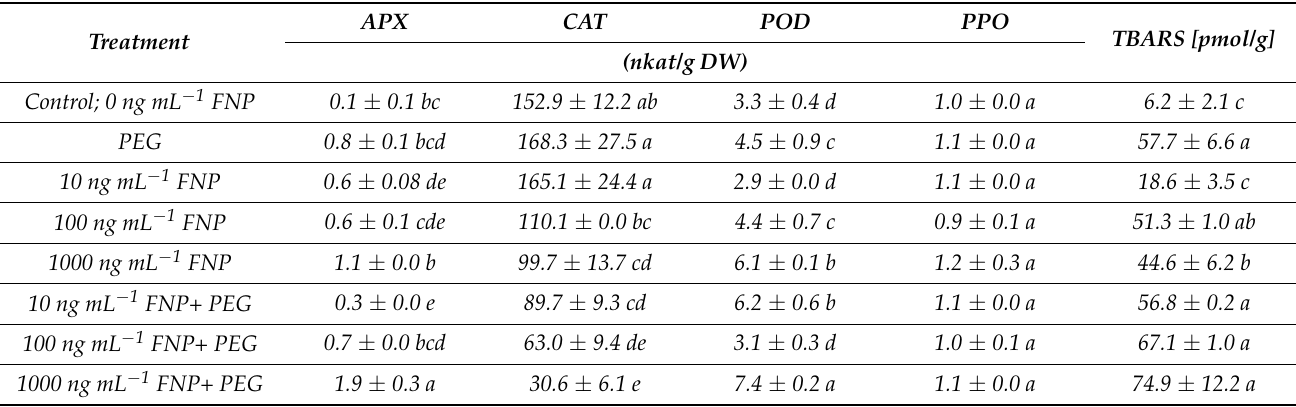
Table 1. Activity of antioxidative enzymes and TBARS content under drought (PEG), fullerol C 60 (OH) 24 nanoparticles (FNP; 0, 10, 100, and 1000 ng mL − 1 ) and combined FNP–PEG treatments (10 ng mL − 1 FNP + PEG, 100 ng mL − 1 FNP + PEG, and 1000 ng mL − 1 FNP + PEG).